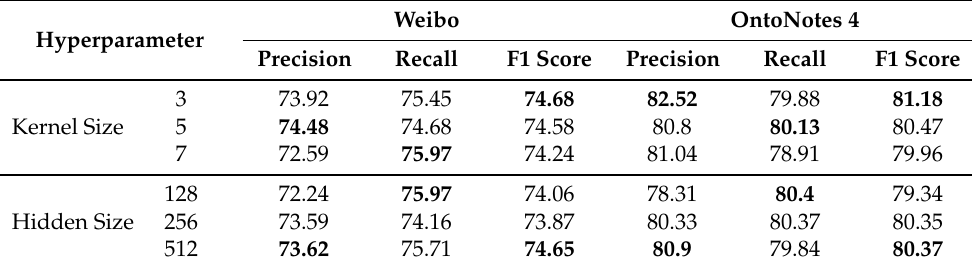
Table 3. The evaluation results of different hyperparameters on the development set. Among them, kernel size represents the size of the context window in CBHNN; hidden size represents the dimen- sions of the hidden state in the semantic encoding